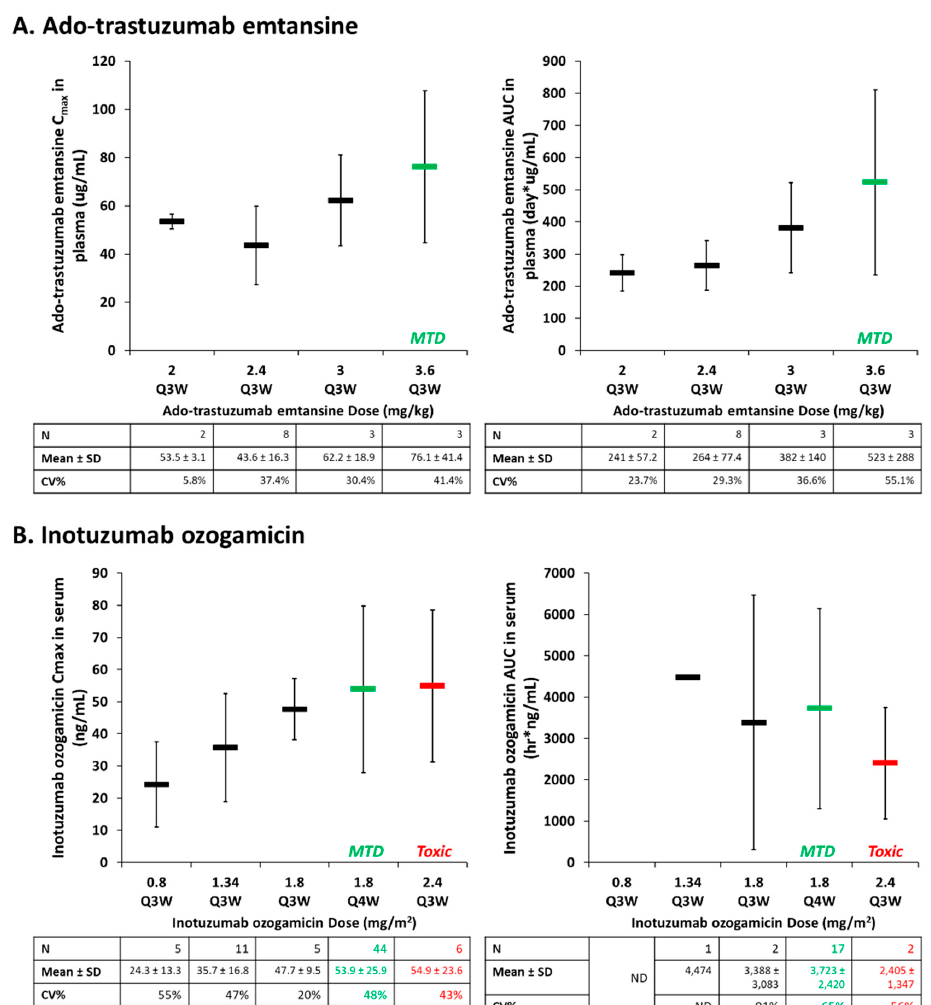
Figure 2. High variability in the pharmacokinetic (PK) of antibody-drug conjugates (ADCs) as represented by the relationship between ado-trastuzumab emtansine (A) and Inotuzumab ozogamicin (B) dose and PK parameters (Cmax, area under the curve (AUC)) in serum. Mean ± standard deviation (SD) of patients for each treatment group are represented by the rectangular bar. There was high inter-patient pharmacokinetic (PK) variability in studies of both solid (breast cancer; ado-trastuzumab emtansine) and hematologic (B-cell lymphoma; inotuzumab ozogamicin) malignancies. The high PK variability observed in these ADC agents may be related to the variability in the mononuclear phagocyte system (MPS). CV%, coefficient of variation; Q3W, every three weeks; Q4W, every four weeks.